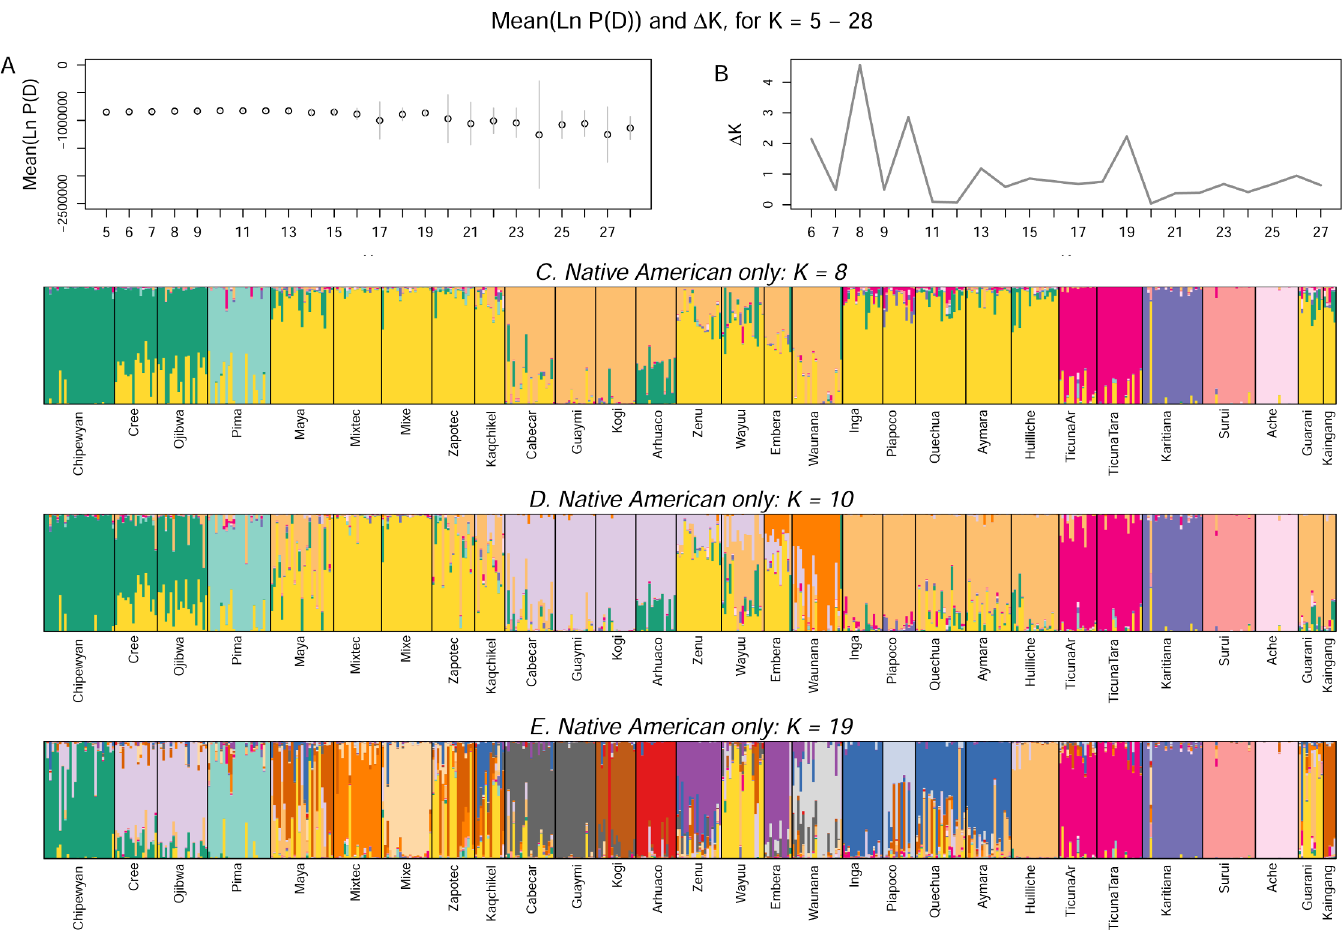
Fig 3. A. Mean log probability of data +/- 1 SD for analyses restricted to the Native American populations at K = 5 – 28. B. Δ K . C — E. Bar charts of individual ancestry for typical runs at K = 8, 10, and 19.